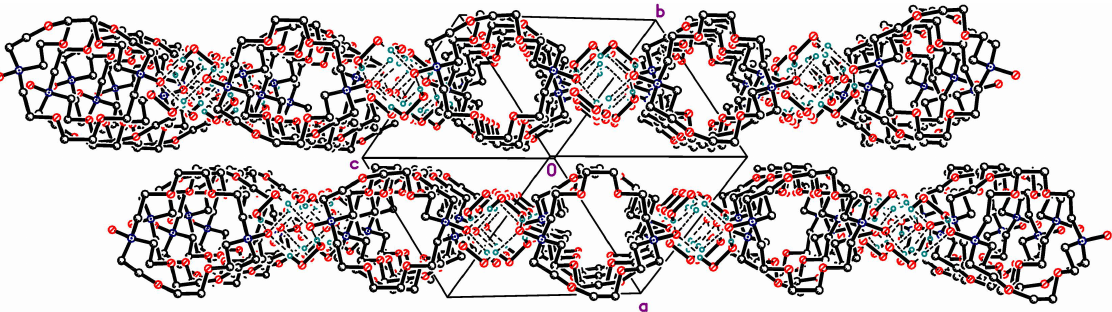
Figure 5. Hydrogen bonded layers in II . View along abc